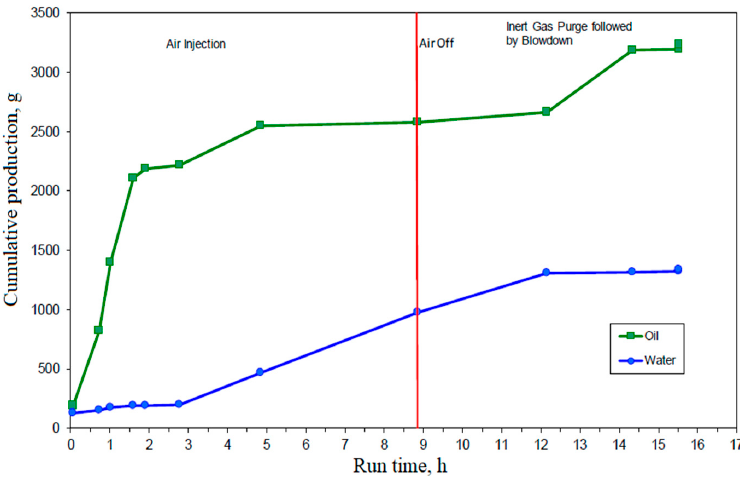
Figure 6. Forward Combustion Oil and Water Production Cumulative Masses (Color should be used). According to the experiment, 3236.5 g of oil were produced, which corresponds to a value of recovery coefficient equal 91.4% taking into account the very small amount of initial oil in lines. Of as fuel, 0.4% was produced as fuel gas, and 2.4% remained as residual in the core.